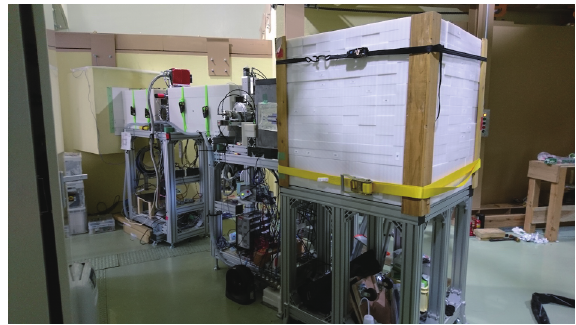
Figure 1. Photograph of NUANS BL2. Left hand side is the proton beam line. The center of the photo is the target